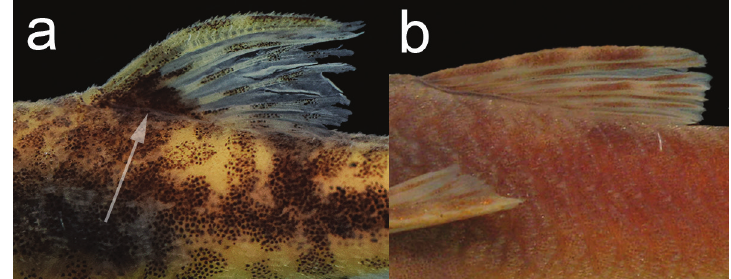
Figure 2. Photographs showing a the presence of a triangular dark blotch at the anterior base of the dorsal fin in P. dani (arrow), holotype, MZUSP 120737, 27.3 mm SL; and b absence of the triangular